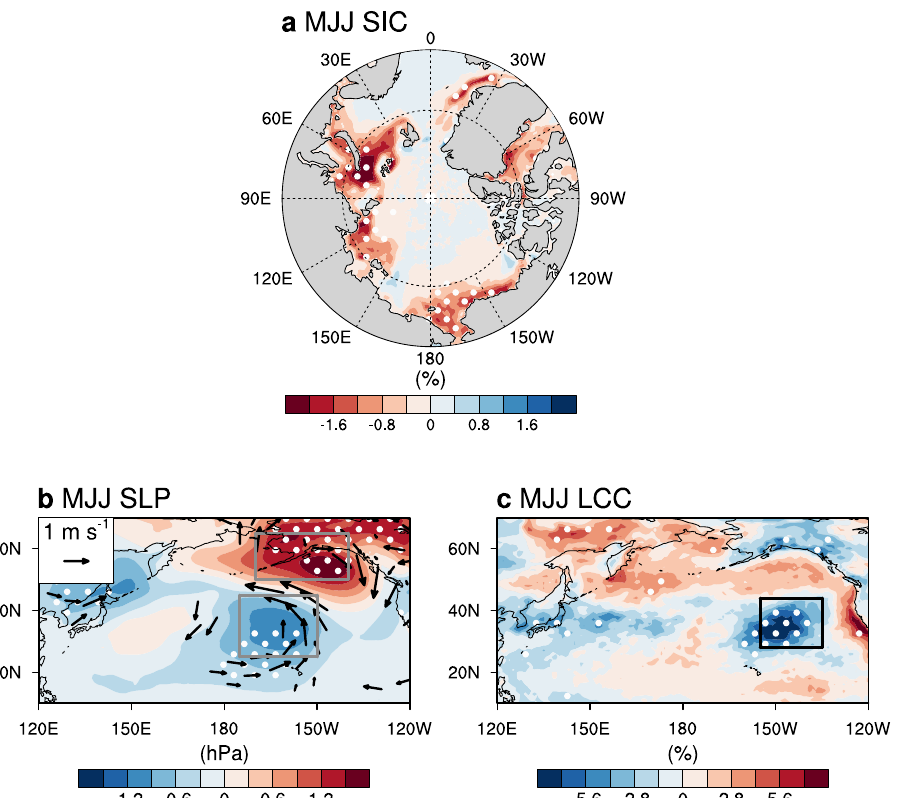
Fig. 2 Preceding conditions of sea ice concentration, atmospheric circulation and low-level cloud cover for the years of long MHW days. Composite map of a sea ice concentration (%), b sea level pressure (in hPa) and 850-hPa winds (m s − 1 ) and c low-level cloud cover (%) during May-June-July (MJJ) for the years (2004, 2009, 2011, 2013, 2014, 2015, and 2019) when the MHW days during JJA were >10 days since the late 1990s. The gray and black boxes in b and c represent de fi nition for the NPO and LCC index, respectively (see “ Methods ” ). Stippling regions in b and c indicate statistically signi fi cant values at the 90% con fi dence level based on a two-sided t